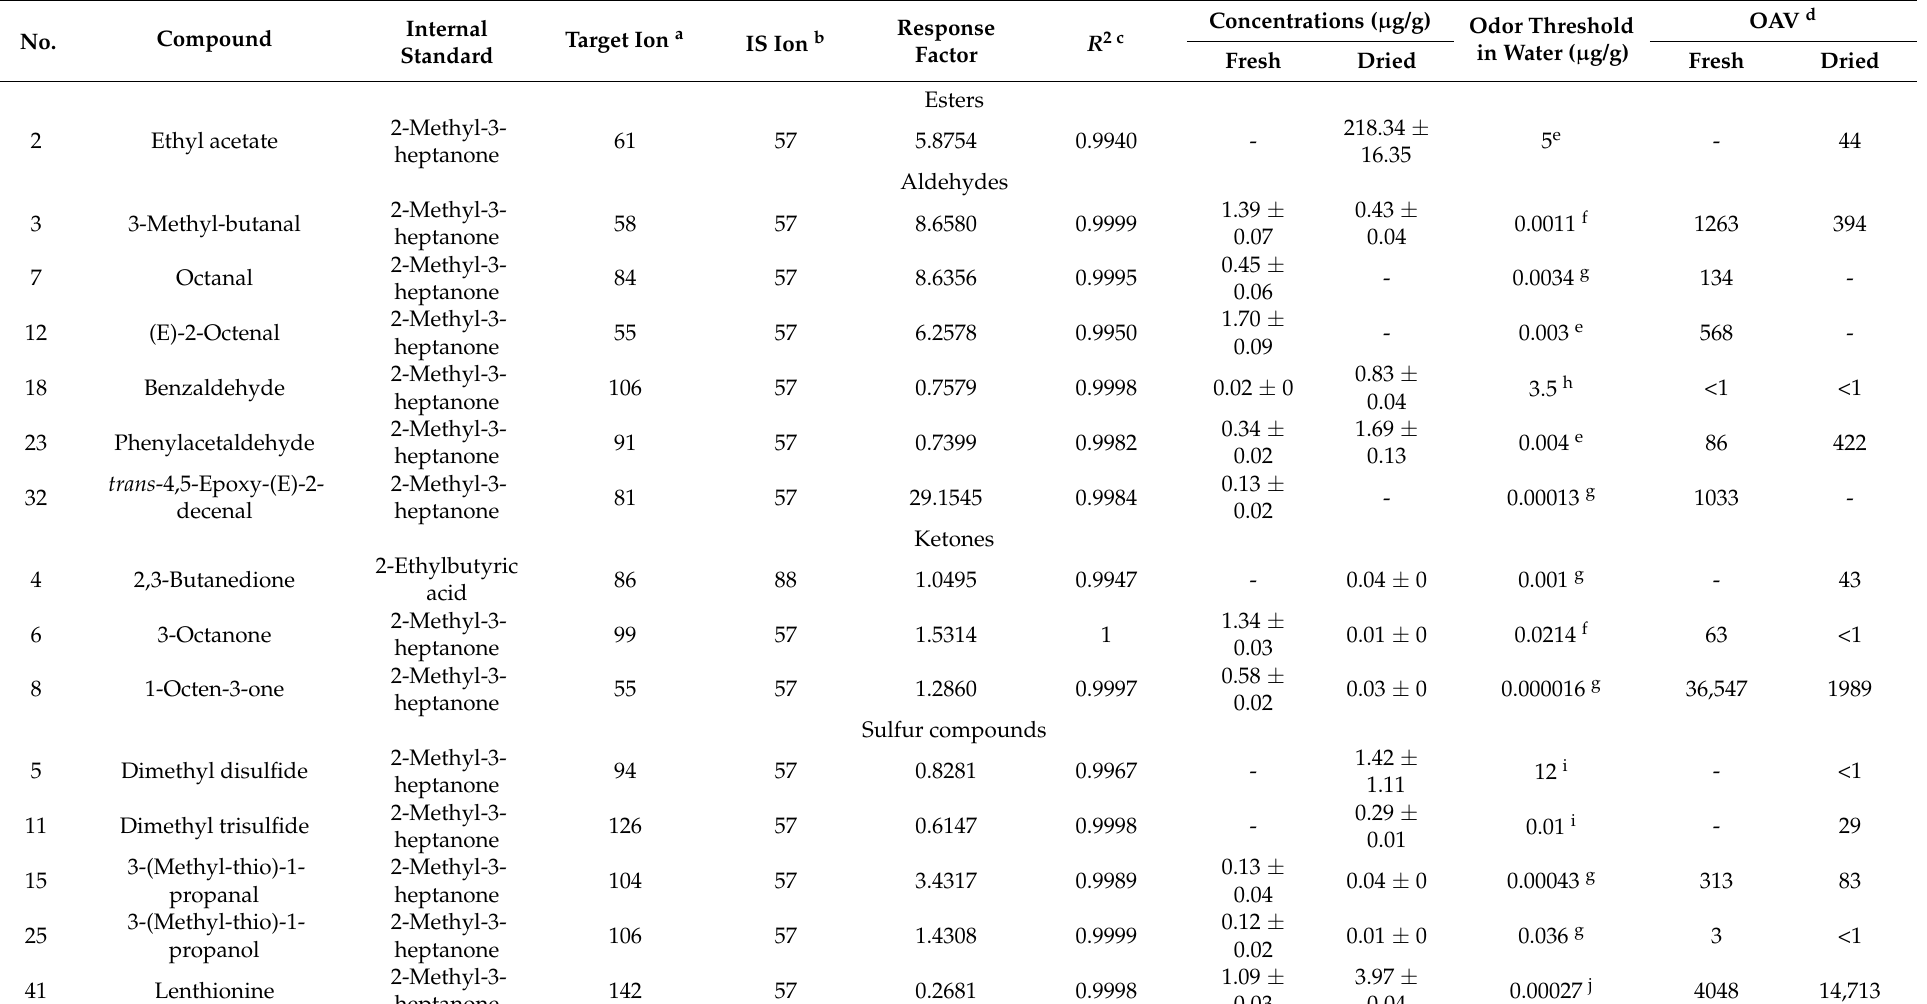
Table 3. Quantification of the predominant odorants in fresh and hot-air-dried shiitake